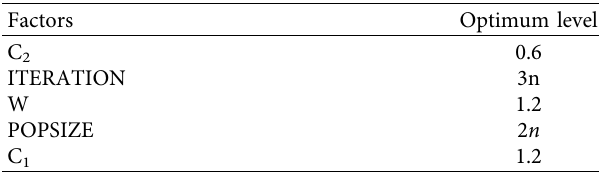
Table 8: Optimal parameters and operators of PSO algorithm.